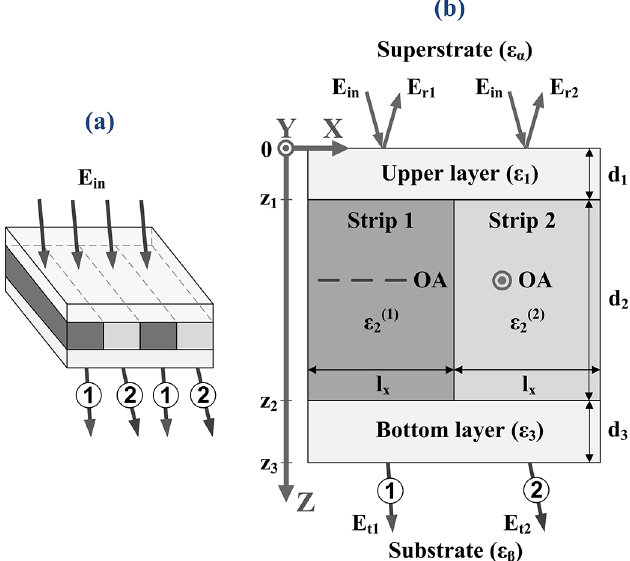
Fig. 1. (a) Scheme of the multilayer with the main composite layer formed from alternating “ strips ” of two different materials that can be optically uniaxial in the general case. The rays in the substrate transmitted through the multilayer are denoted by numbers 1 and 2. E in is the incident wave fi eld, the re fl ected rays in the superstrate are not shown. (b) Geometry of the corresponding electromagnetic boundary problems. The multi- layer includes upper and bottom layers, which electromagnetic properties can correspond to isotropic ENZ MMs or metals, and the main layer. The superstrate and substrate materials are isotropic and optically thick. E r1 , E r2 , and E t1 , E t2 are the fi elds of the waves re fl ected from and transmitted through Strips 1 and 2, respectively, when the incident wave interacts with the multilayer. OA denotes the optical axis direction in the materials of Strips 1 or 2. The other denotations are given in the main